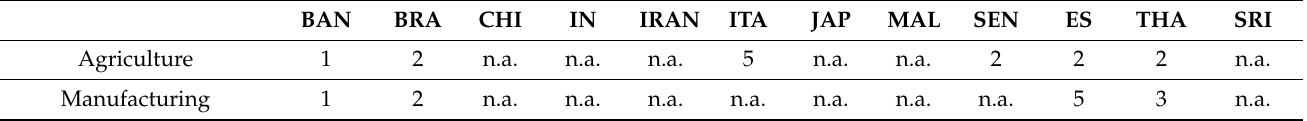
Table 5. Risk of discrimination due to the large share of migrant workers in the rice sector [69]. BAN BRA CHI IN IRAN ITA JAP MAL SEN ES THA SRI 2 n.a. n.a. n.a. 5 n.a. n.a. 2 2 2 n.a. 2 n.a. n.a. n.a. n.a. n.a. n.a. n.a. 5 3